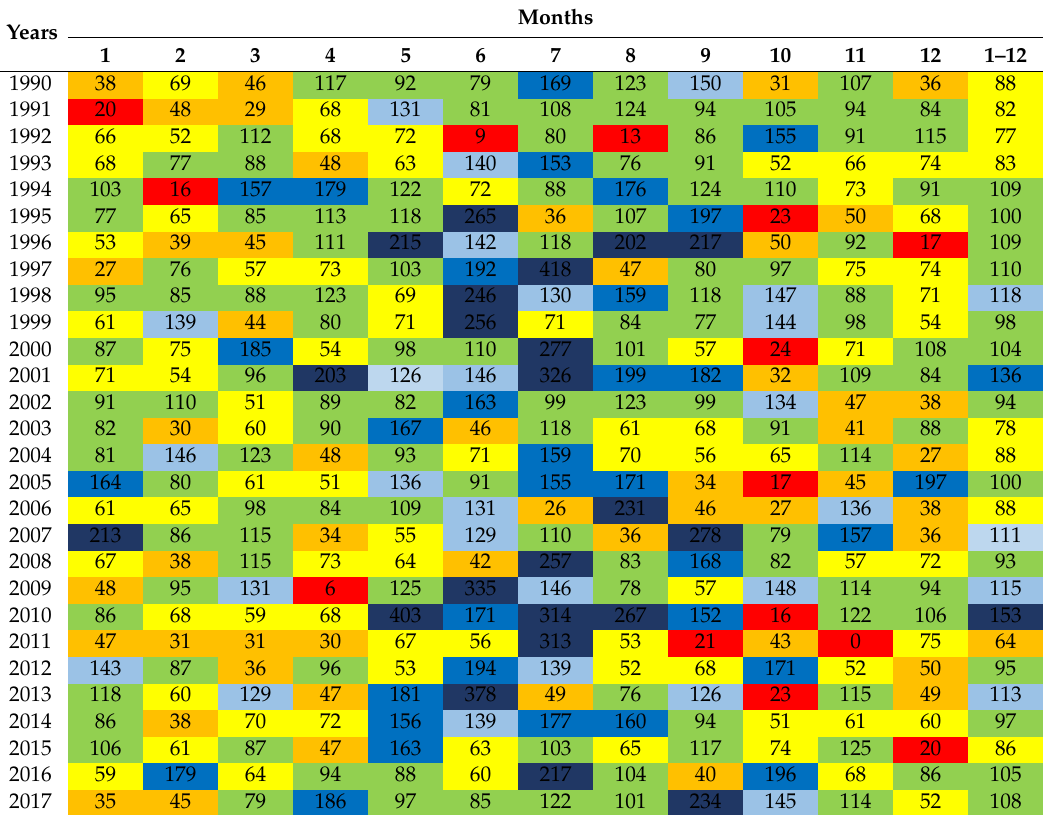
Table 3. RPI index values (%) and pluvial classification of months and years for the Pr ˛adnik basin in the period 1990–2017.